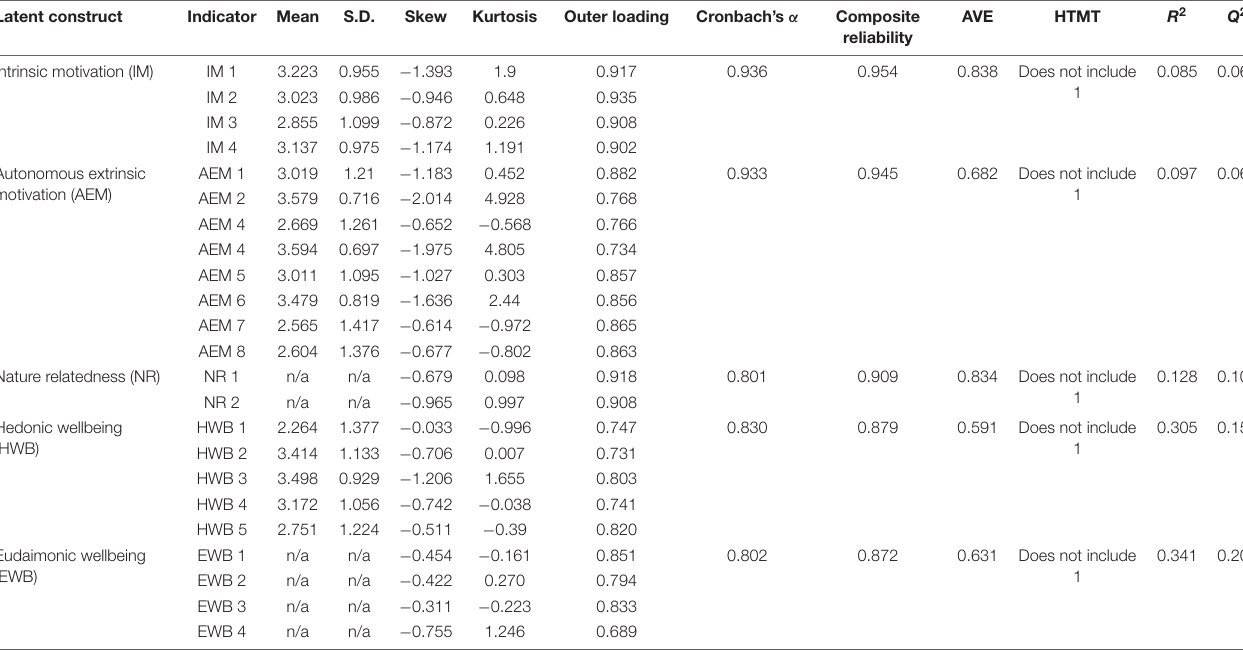
TABLE 2 | Measurement model evaluation. Latent